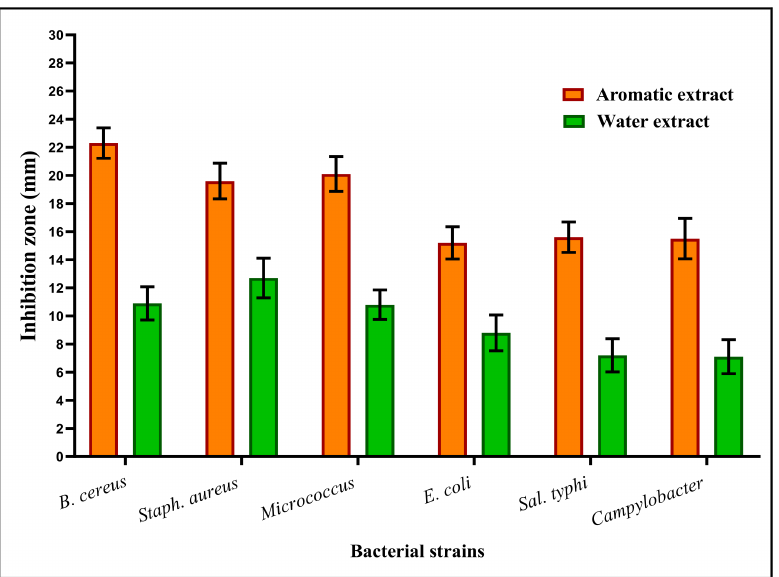
Figure 1. Antibacterial of a mixture (ginger:thyme:coriander) extract types against pathogenic bacterial strains. Results were expressed as means ± S.D. (n = 3), inhibition zone diameter represented in millimeters. The aromatic extract was applied in the nano-form of chitosan nanoparticles.